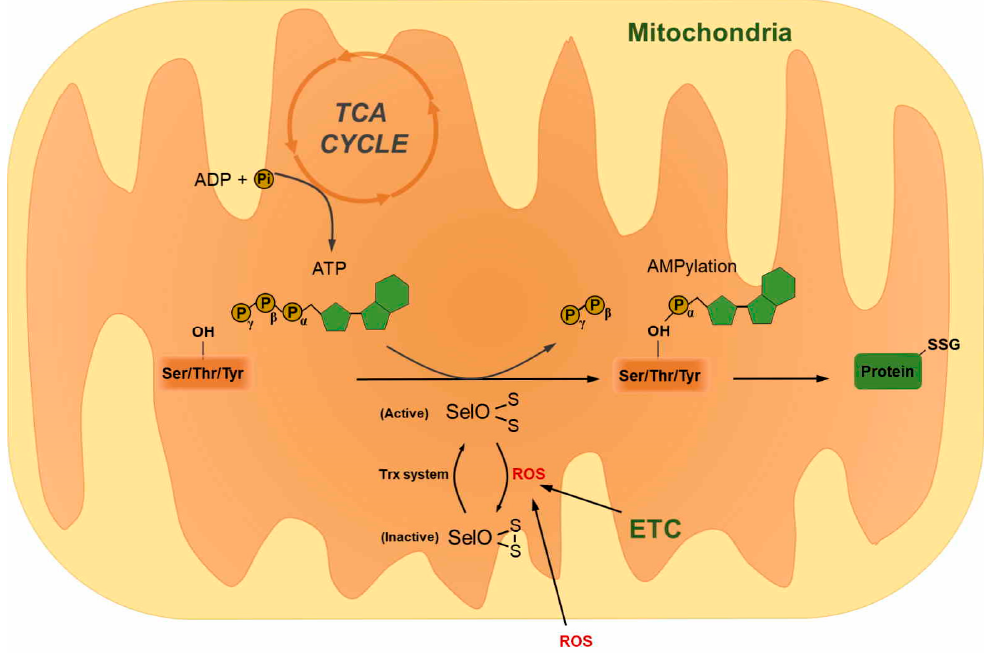
Figure5. Figure 5. Selenoprotein O (SelO) mediates protein AMPylation and protects the cell from oxidative stress.